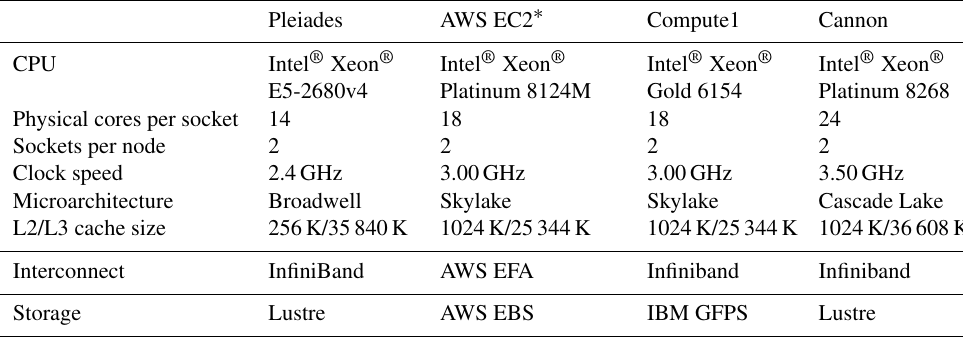
Table 4. Summary of architectures used to evaluate GCHP performance.